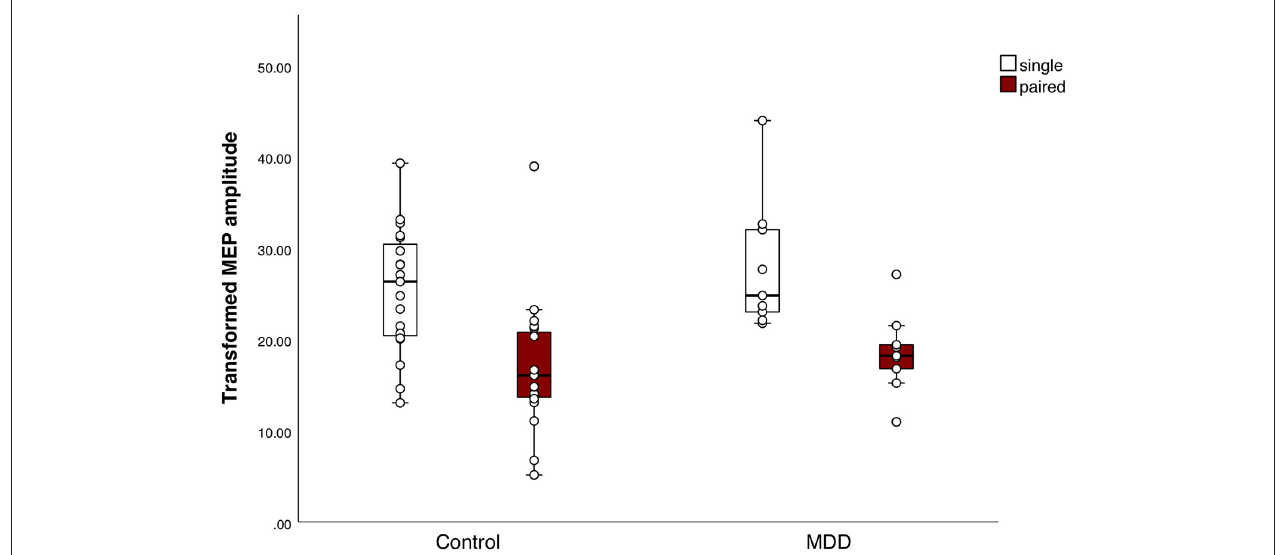
FIGURE 2 | Response to the short interval cortical inhibition (SICI) paradigm. Boxplots of square-root (sqrt) transformed mean motor evoked potential (MEP) amplitudes per subject in response to the SICI, for both groups separately. Mean MEP amplitudes in response to the single pulses or paired pulses did not differ between the major depressive disorder (MDD) group and the control group. Mean MEP amplitude differed significantly between conditions, indicating that the SICI paradigm sufficiently inhibited the MEPs in both groups ( F (1, 25) = 44.0, p < 0.001, η 2 = 0.6).